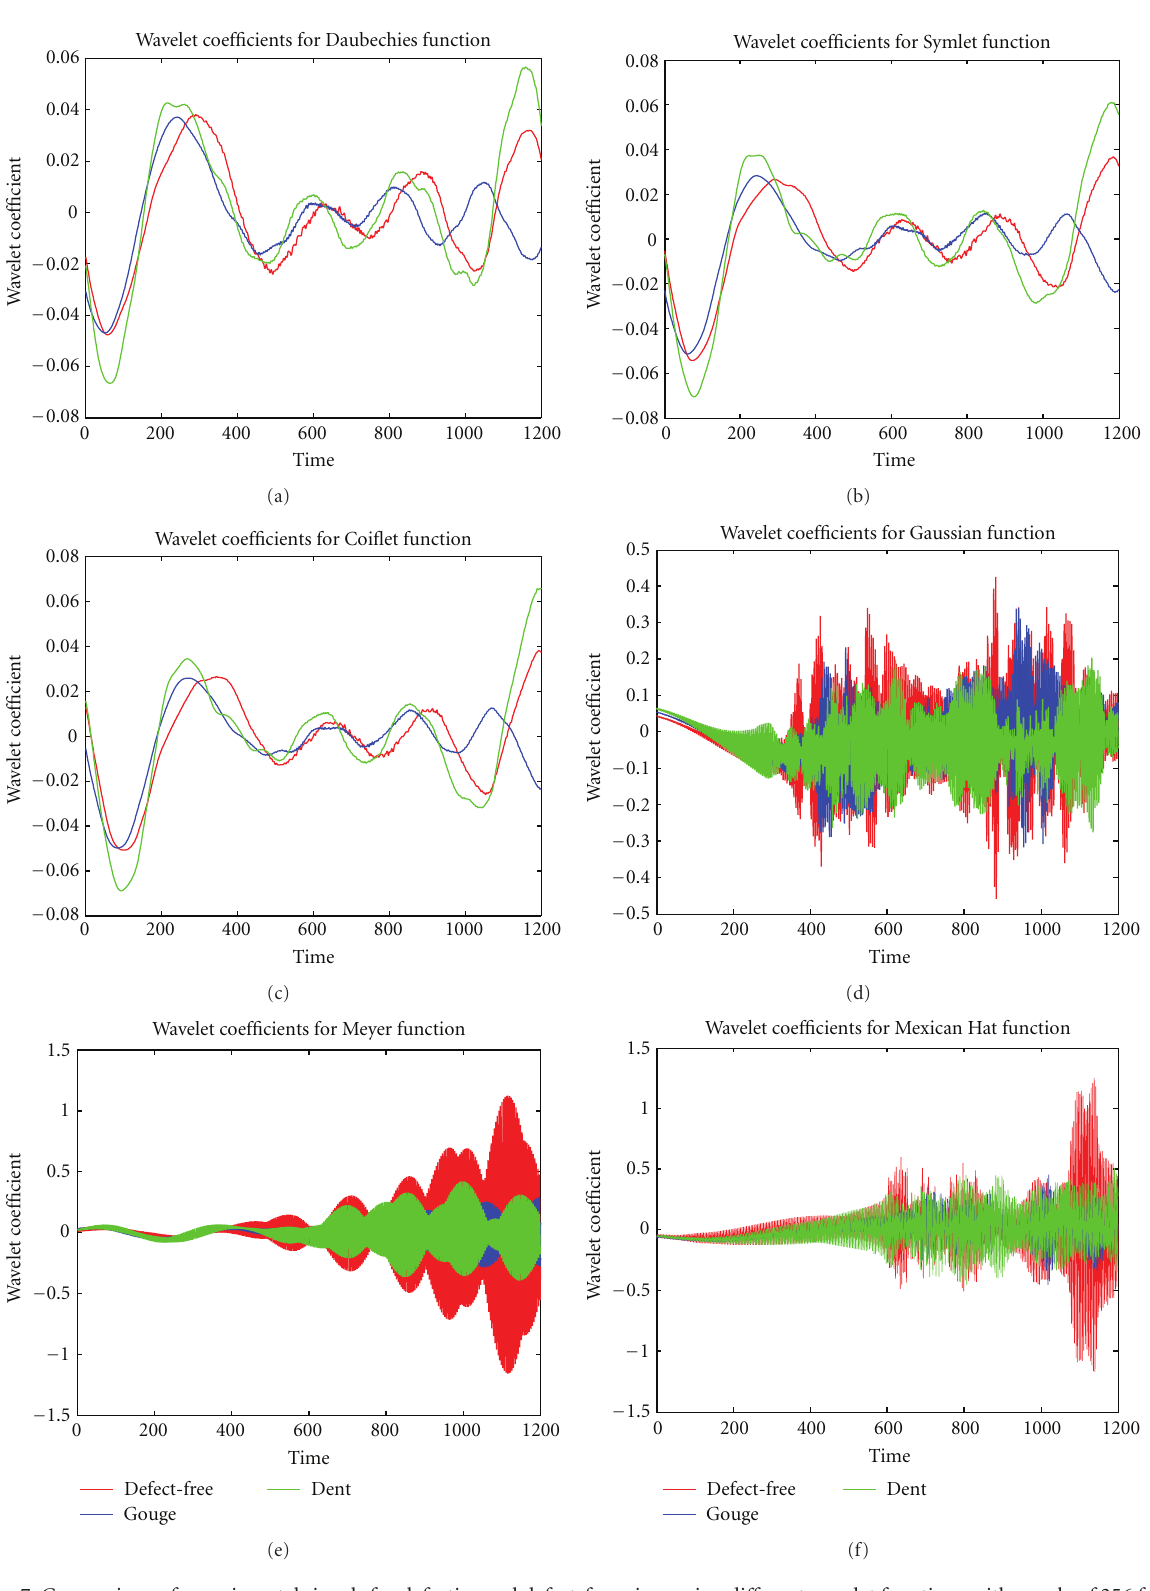
Figure 7: Comparison of experimental signals for defective and defect-free pipes using di ff erent wavelet functions with a scale of 256 for (a) db4, (b) sym4, (c) coif2, (d) gauss1, (e) Meyer, and (f) Mexican hat wavelet